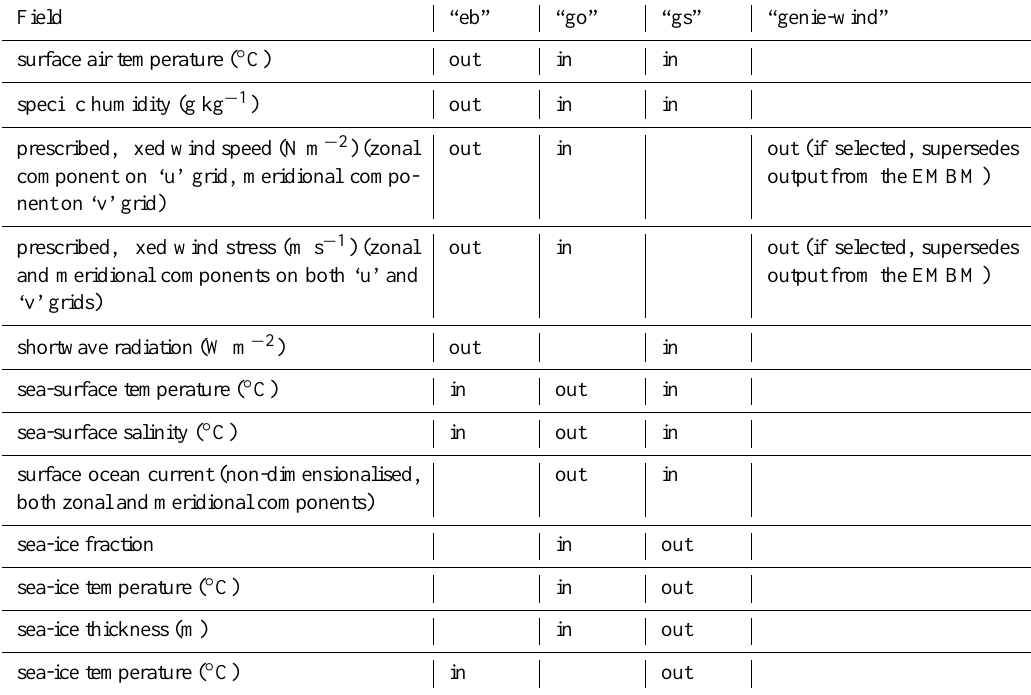
Table 2. Input/output fields to/from the individual modules. Note, while for eb go gs configurations (as for C-GOLDSTEIN, see EM05), we define neither land temperature nor standing water on land, differences between air and land temperatures, as well as land moisture, are important coupling quantities when other land options are used, and so are made available when eb go gs is coupled to the land surface scheme (“ENTS”) of Williamson et al. (2006). Also, when the atmospheric chemistry module (“ATCHEM”) is included, further input to the atmosphere include greenhouse gas concentrations. When the ocean module is coupled to the ocean biogeochemistry module (“BIOGEM”) a range of fields from the three modules are made available to BIOGEM, including a number of passive oceanic tracers which are subjected to ocean transport and are modified by